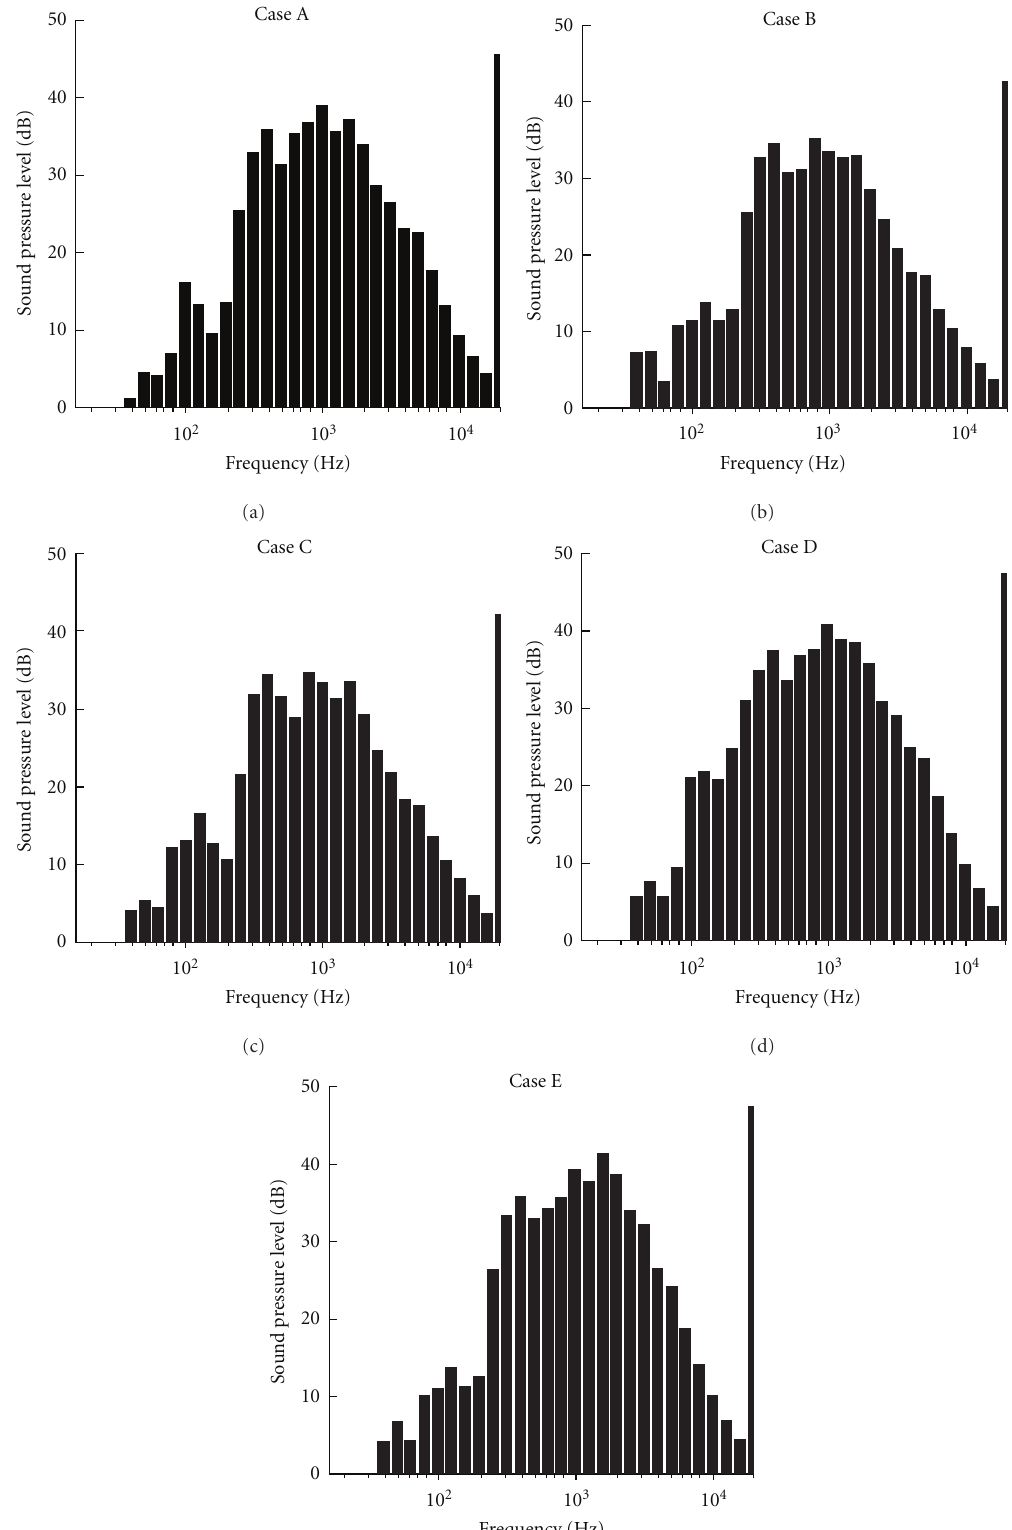
Figure 10: The 1/3 octave band spectra of noise from the tested CFF using porous